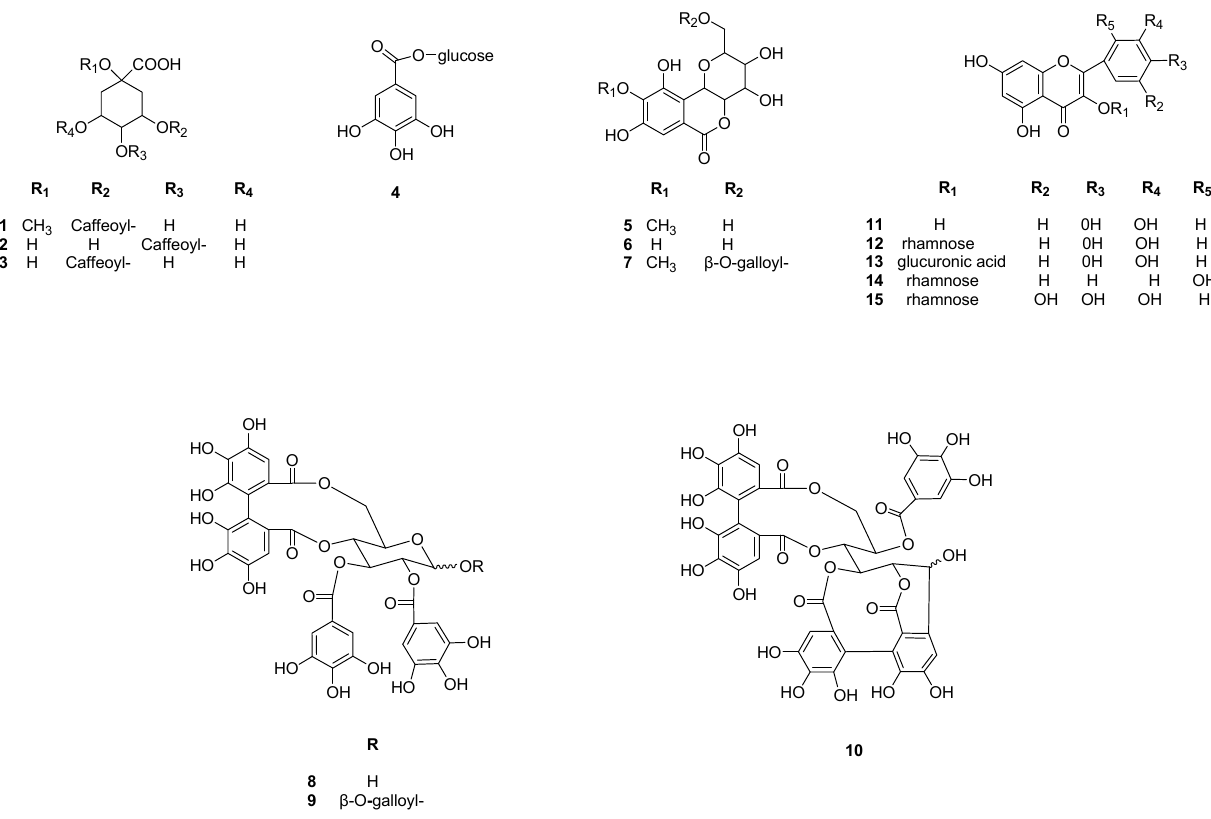
Figure 1. Structures of compounds 1 – 15 isolated from